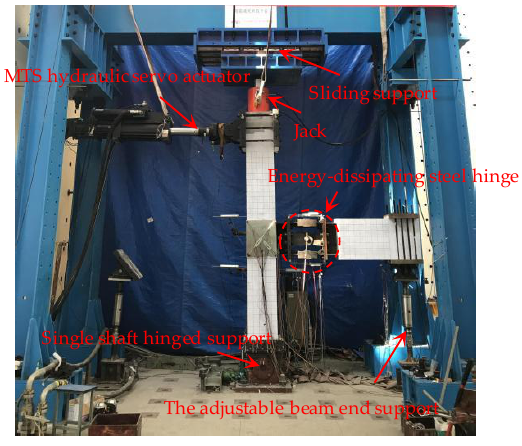
Figure 6. Test set-up.